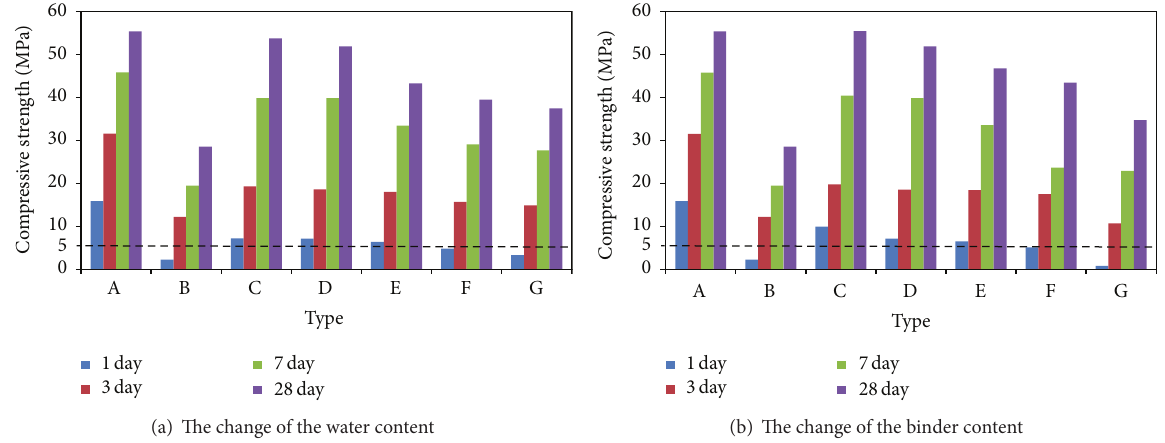
Figure 3: The compressive strength of high volume fly ash